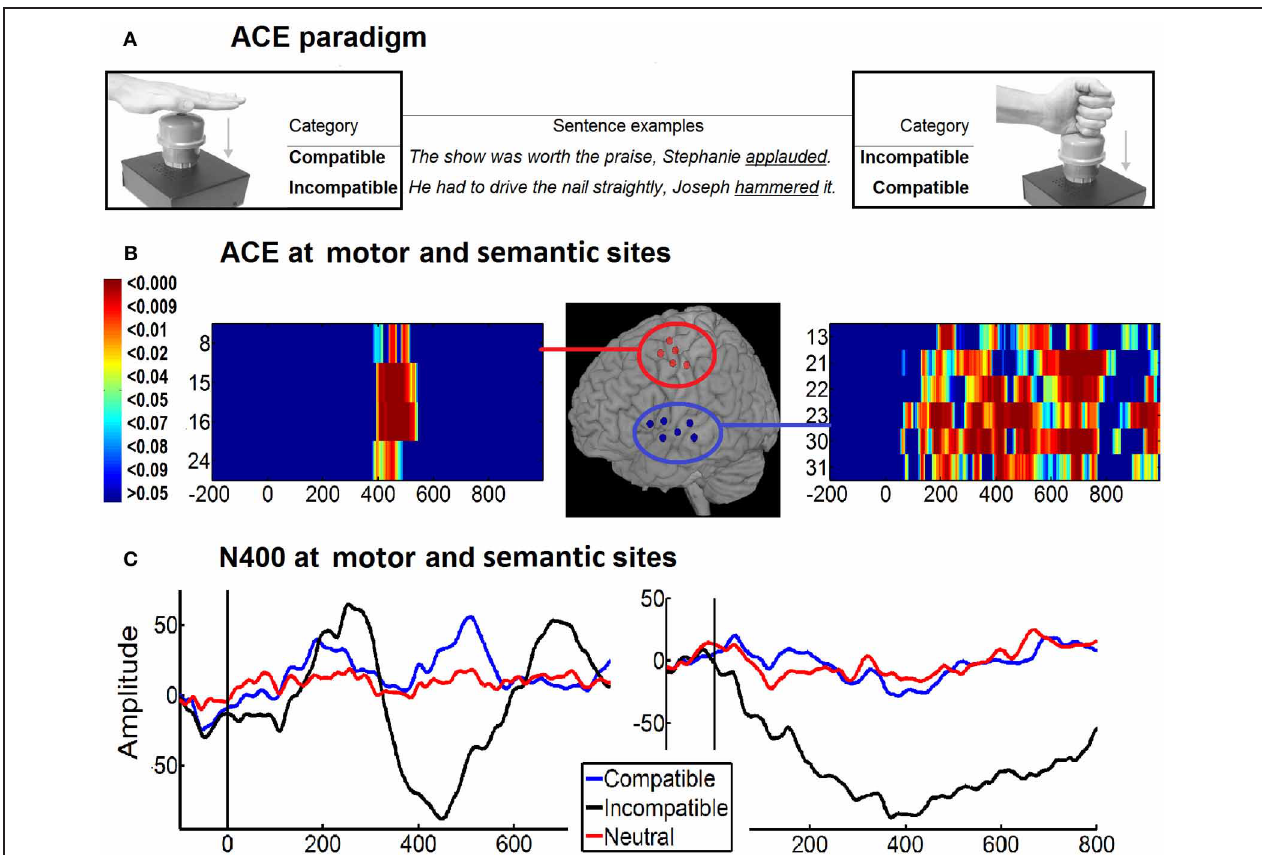
electrodes showing a significant ACE (compatibility effect: incompatible minus compatible differences) at IFG, STG, and MTG (semantic-related areas, Blue circle) and the PM and M1 (motor-related areas, red circle). The time-probability charts show electrodes significant effects at N400 windows [M-N400 localized in premotor/motor (right side) and at temporal areas (left side)]. (C) Intracranial ERPs of Motor N400 (390–500 ms) and temporal N400 (250–700 ms) for compatible, incompatible and neutral categories. Modified with authorization from Cortex (Ibáñez et al., 2012a).